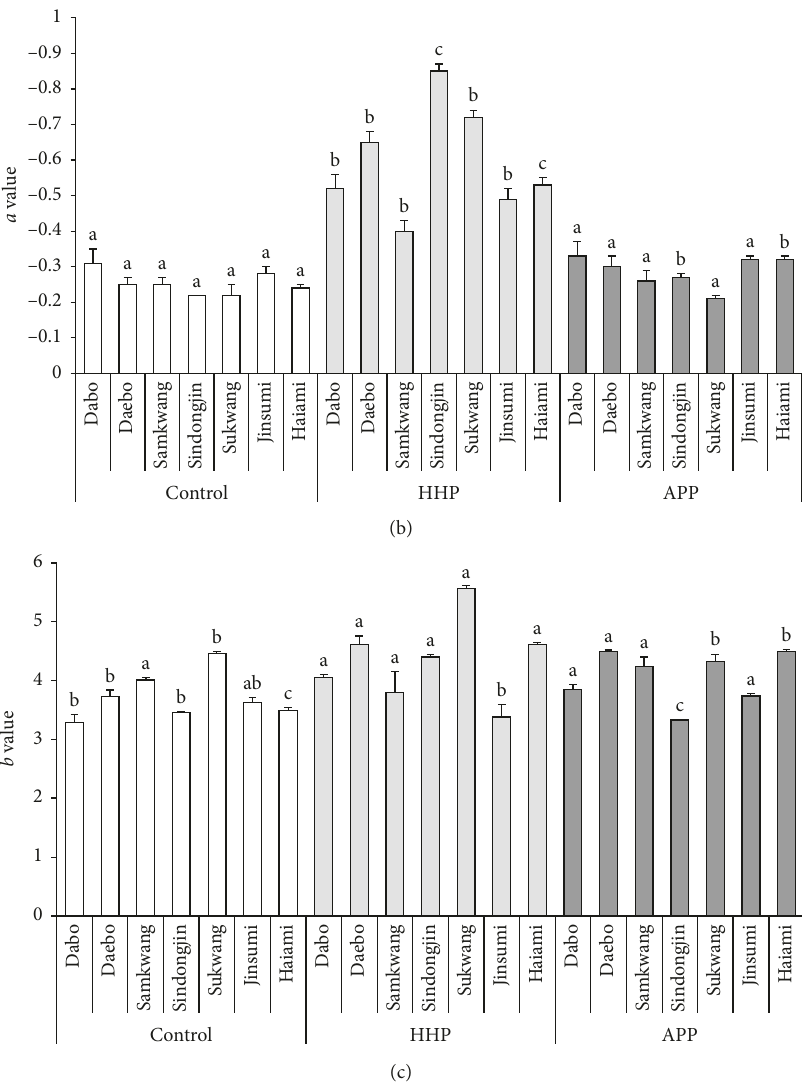
Figure 4: Colorimetry analysis of rice. Samples were treated by high hydrostatic pressure or atmospheric pressure plasma, and colors were compared to control. Values with different superscripts are significantly different at p the same